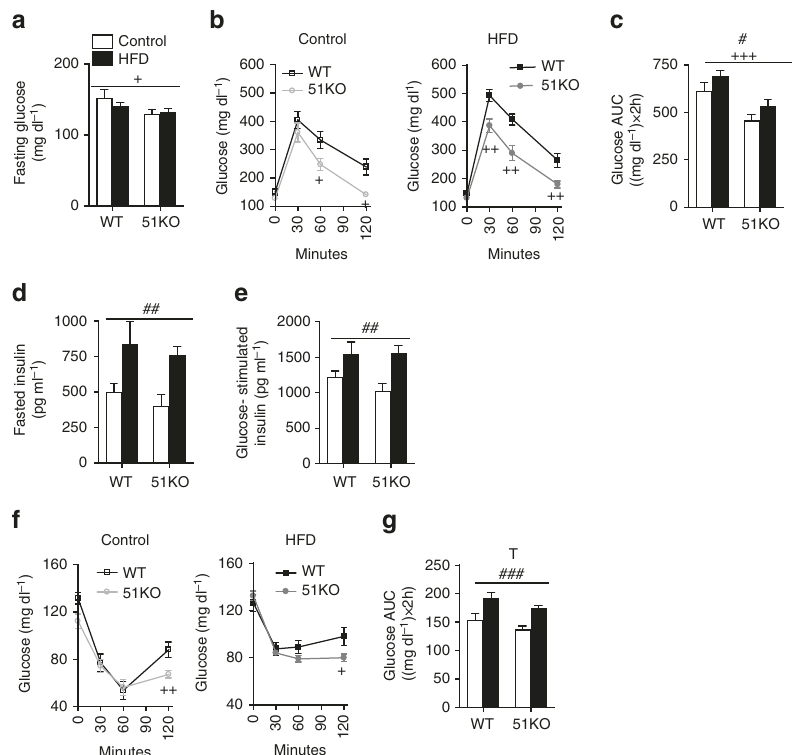
Fig. 2 Genetic ablation of FKBP51 improves glucose tolerance. a Blood glucose following a 14 h fast was signi fi cantly lower in 51KO mice compared to WT mice. b In the GTT, a HFD impaired glucose tolerance in WT mice but not in 51KO mice. c The glucose area under curve (AUC) illustrates the effect of genotype and diet on glucose tolerance. d , e Fasted insulin and glucose-stimulated insulin were signi fi cantly elevated from HFD exposure independent of genotype. f In HFD-fed mice, loss of FKBP51 signi fi cantly reduced insulin tolerance. Importantly blood glucose remained signi fi cantly lower 120 min following insulin administration on account of FKBP51 deletion under both chow conditions and HFD conditions. g The glucose AUC for ITT demonstrates the strong diet effect and a trend for genotype. n = 8 WT-Control, n = 10 WT-HFD, n = 12 51KO-Control, n = 13 51KO-HFD. Data are represented as mean ± SEM. + P < 0.05, ++ P < 0.01, +++ P < 0.001; # P < 0.05, ## P < 0.01, ### P < 0.001, T P < 0.1, two-way ANOVA for a , Repeated measures ANOVA for b , f